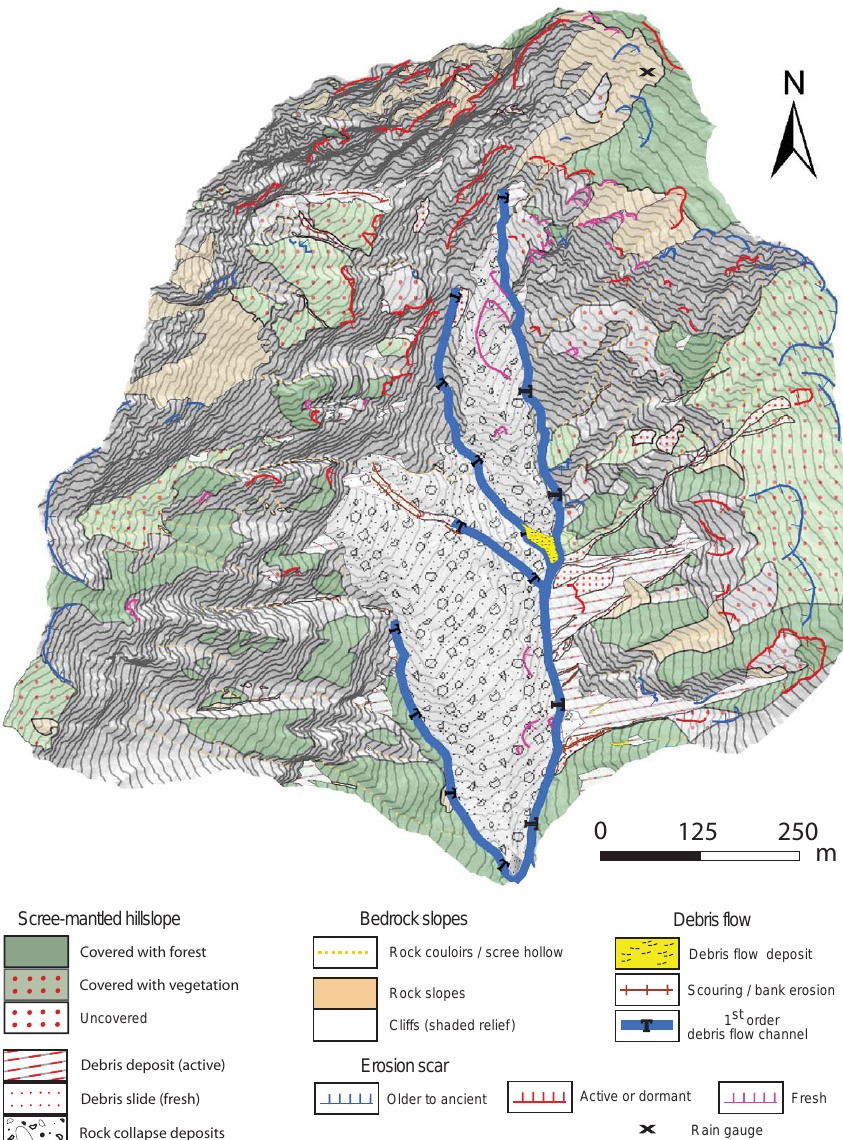
Figure 4. Geomorphic process map (contour interval: 20m) illustrating the spatial pattern of sediment sources and transfer in the first-order channel complex. Note the impressive rock collapse deposits now crossed by four first-order debris channels. Their bed incision is strongly constrained by a series of check dams (marked as black “T” on the map), but erosion scars all along the deposit suggest that the reaches are still subject to lateral